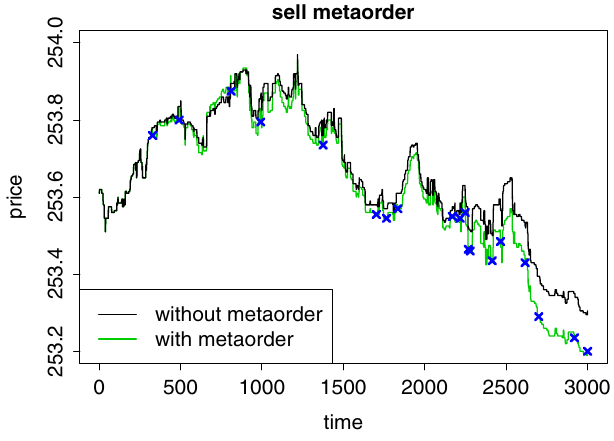
FIG. 6. The price process with and without the metaorder trading, with the same random seed used for the two simulations. The black curve shows the price dynamics without the meta- order, while the green curve shows it with the metaorder. Trades of the metaorder are denoted by blue crosses. In the simulations we used the parameters, (cid:10) ¼ 0 : 8 , (cid:11) ¼ 0 : 65 , (cid:5) 1 ¼ 10 (cid:2) 4 , (cid:4) ¼ 0 : 5 . The participation rate of the metaorder is (cid:2) ¼ 0 : 05 metaorder to sell is added to the market. The black curve shows the price dynamics without the metaorder, while the green curve shows it with the metaorder trades (the meta- order starts at time 0 and finishes at time 3000). Blue crosses indicate the moments when a trade by the extra agent was made. The agent follows the (cid:11) -execution strat- egy in this particular run. For a while the two curves are identical, then after the first trade of the metaorder the two curves start to deviate from each other. The coarse-grained dynamics of the two curves are similar, however, the final price in case of the green curve is pushed down as a result of the extra sell metaorder.